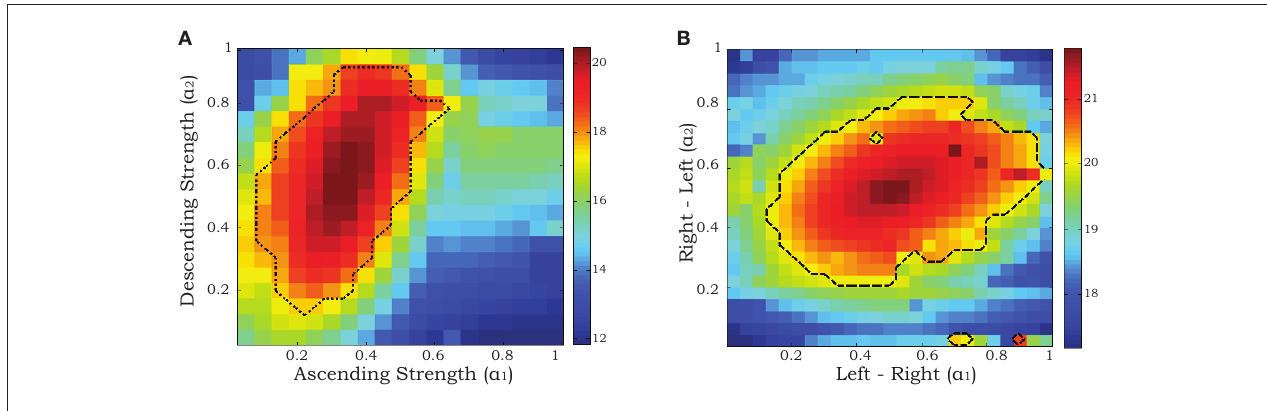
Figure 6 | Maximum log-likelihoods for the data from recorded pairs of motor units (ipsilateral r2–r3 in A and contralateral r2–L2 in B) for the stochastic phase model with fixed values of coupling strengths α regions based on likelihood-ratio tests (see Materials and